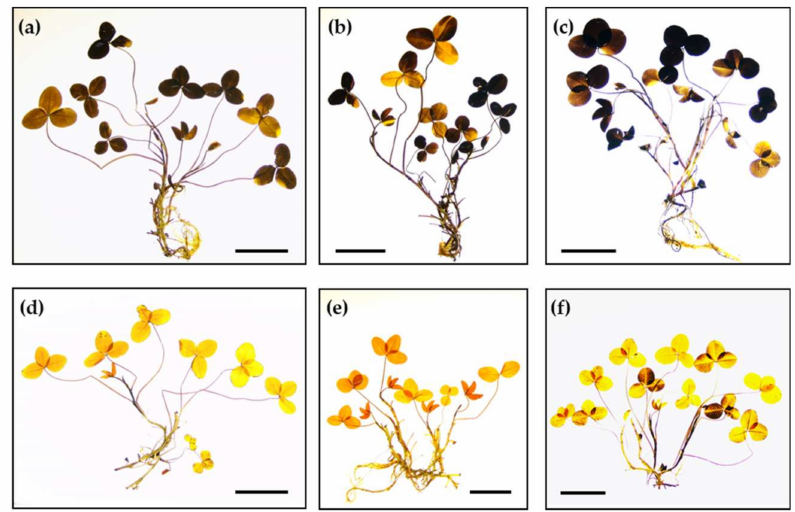
Figure 8. Staining of starch in white clover leaves at ED and at EN shows different patterns of localization across genotypes. Starch is indicated by the dark purple to black color in the leaves. Genotypes TrLB132 ( a ); TrLB085 ( b ); and TrLB028 ( c ) stained at ED. Genotypes TrLB132 ( d ), TrLb085 ( e ), and TrLB028 ( f ) stained at EN. Bars = 5